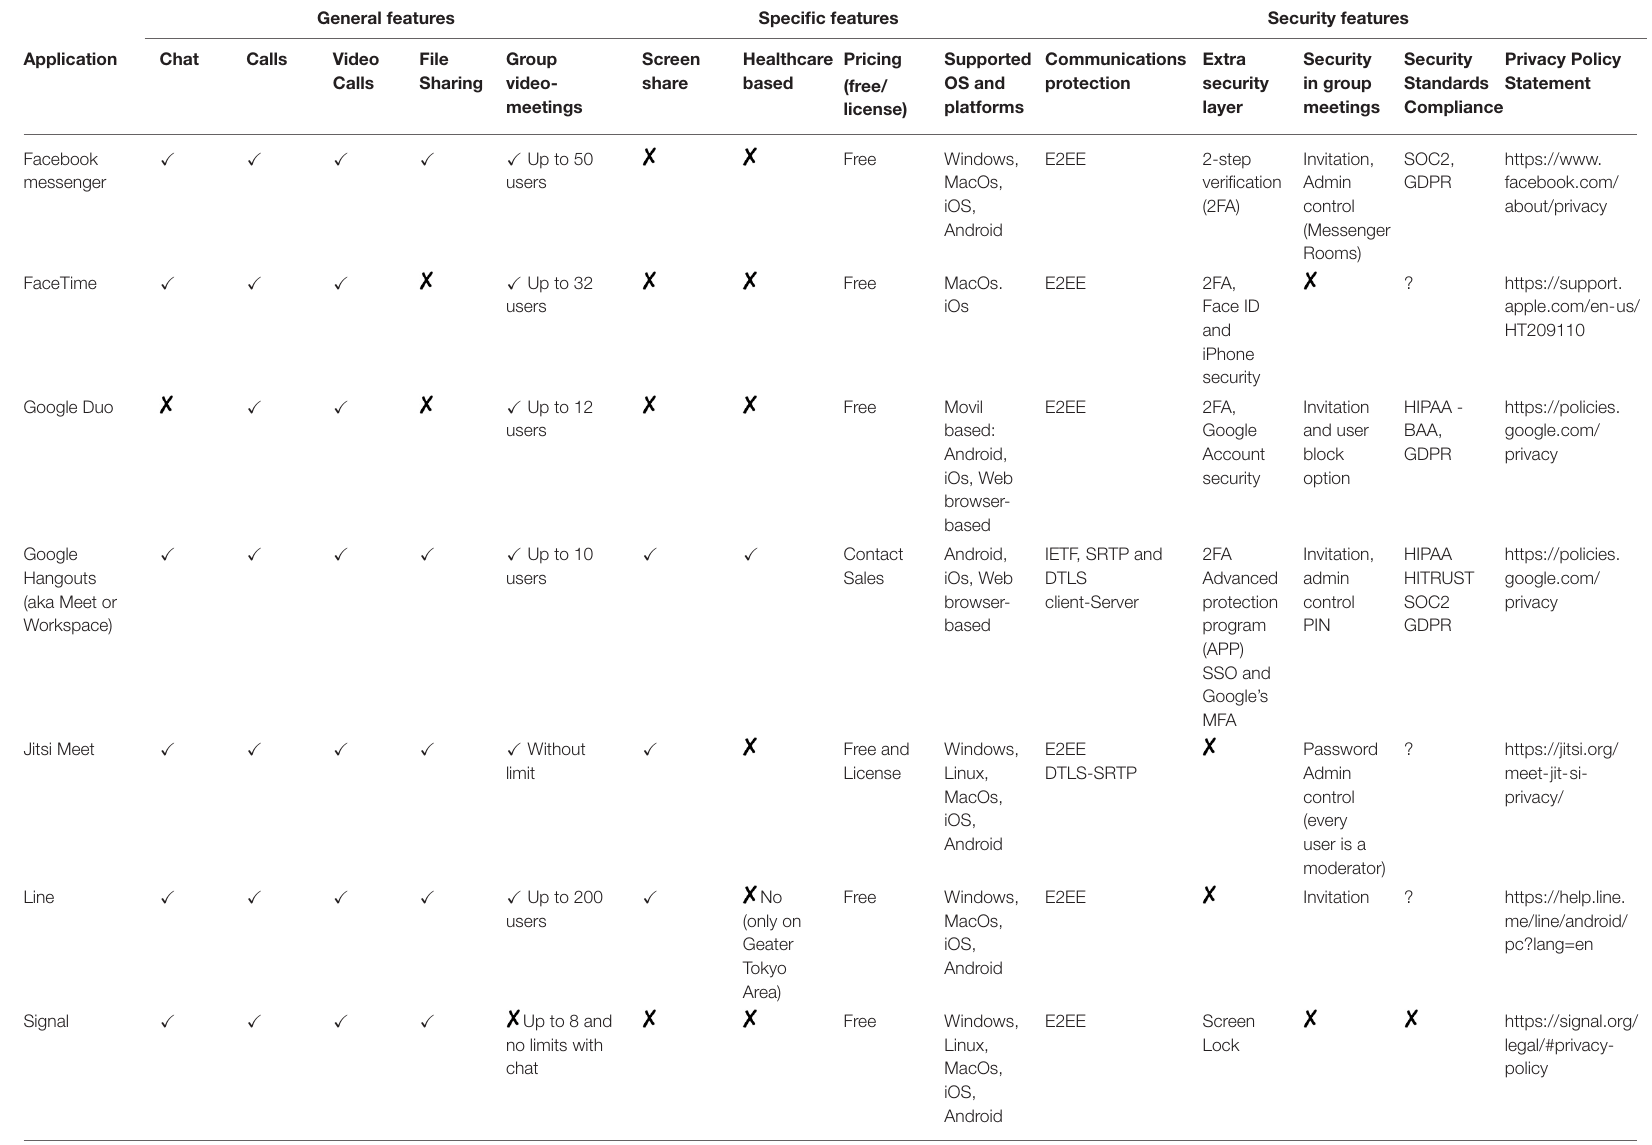
TABLE 1 | Widely Known applications for